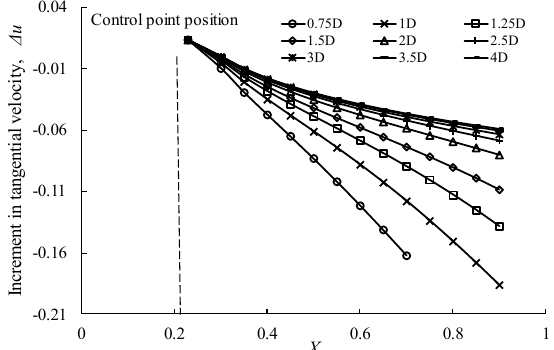
Figure 8. Distributions of tangential velocity increment on the train for various wake lengths.